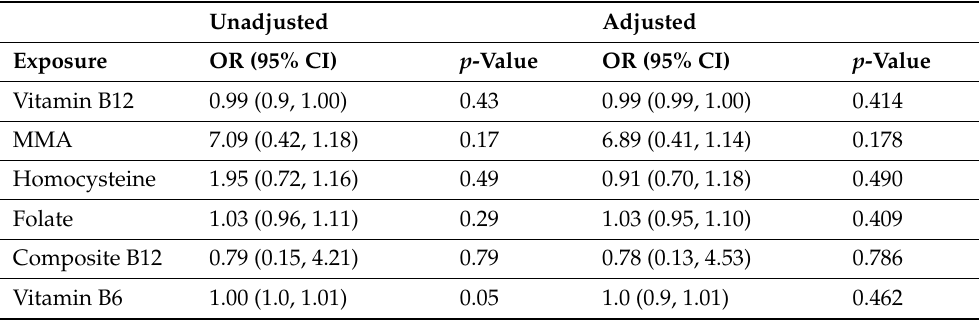
Table 6. Association between maternal B6, B12, and folate with preterm delivery at birth in the MAASTHI cohort. Unadjusted Adjusted